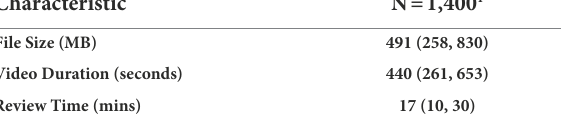
TABLE 2 TREE video descriptive